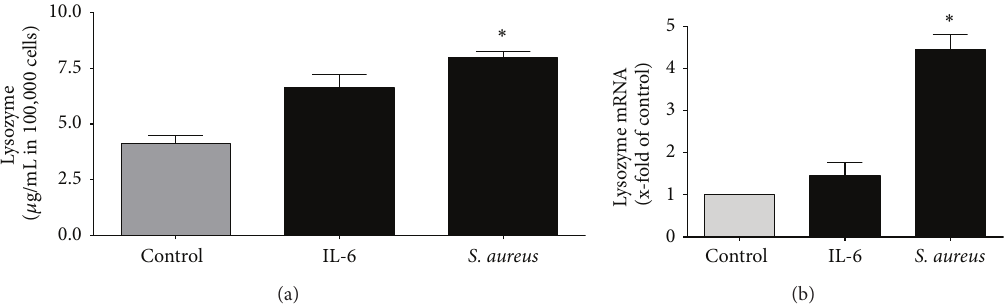
Figure 5: Induction of lysozyme in hepatocytes . (a) HepG2 cells were incubated with IL-6 and S. aureus for 24 hours. Significant increase of lysozyme concentration was detected by ELISA after stimulation with S. aureus . (b) To evaluate transcriptional induction of lysozyme, cultivated hepatocytes (HepG2) were stimulated with IL-6 and S. aureus . Gene expression of lysozyme was measured by real-time PCR after stimulation; ∗ 𝑃 < 0.01 .